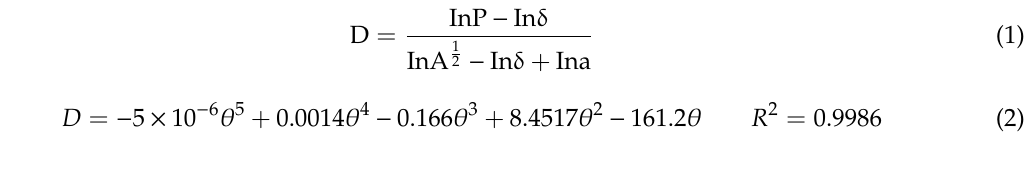
Table 5. E ff ects of surfactant on the fractal dimension of phosphogypsum.